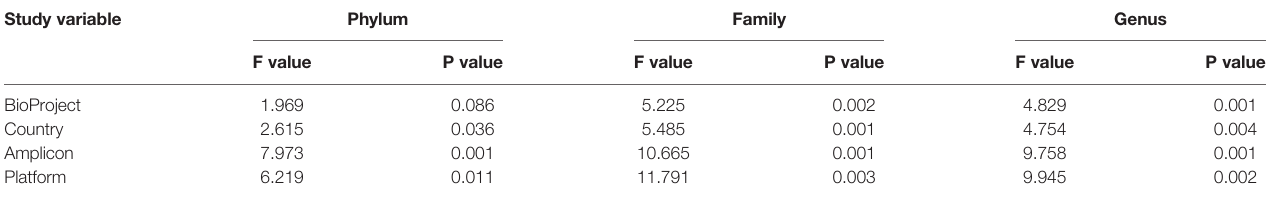
TABLE 6 | Study variable BETADISP analysis of Bray-Curtis distances between DD positive skin microbiota grouped at different taxonomic levels. Study variable